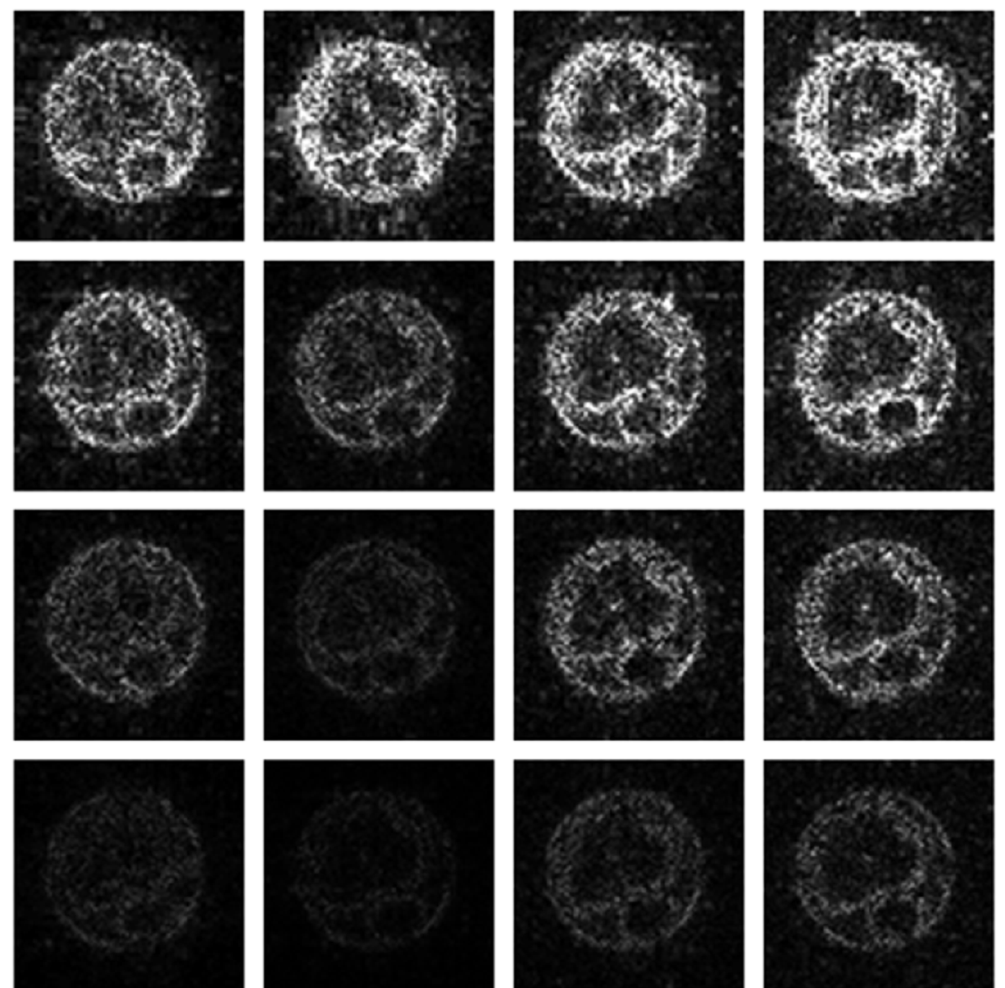
Figure 5. Difference Images from ex vivo reconstruction. Top row—same sampling pattern, row-sparse recovery; 2nd row—same sampling pattern, rank-deficient row-sparse recovery; 3rd row—different sampling pattern, group-sparse recovery; 4th row—different sampling pattern, rank-deficient group-sparse